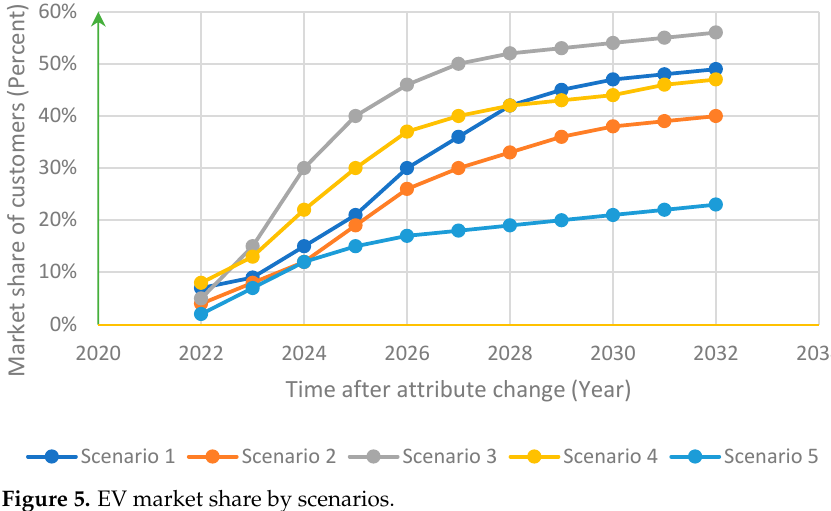
Figure 5. EV market share by scenarios.